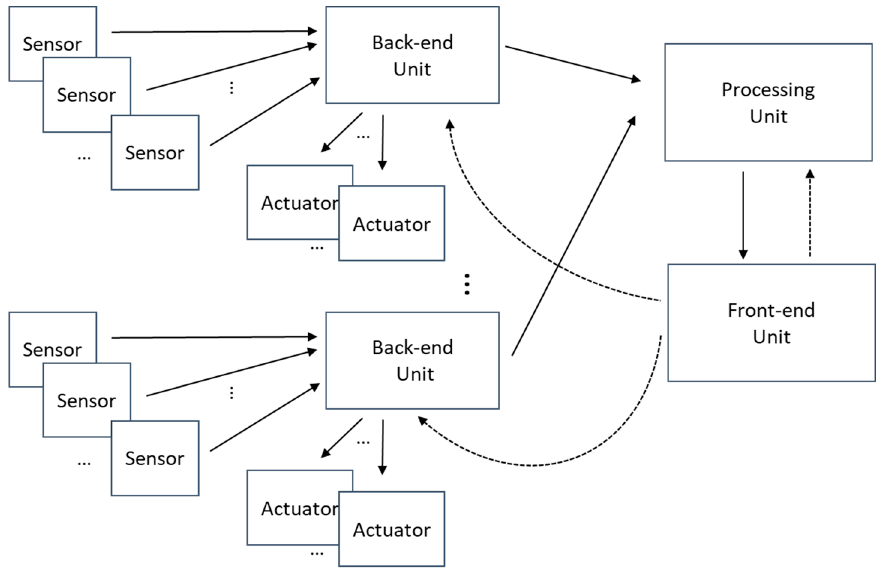
Figure 1. Proposed system architecture.